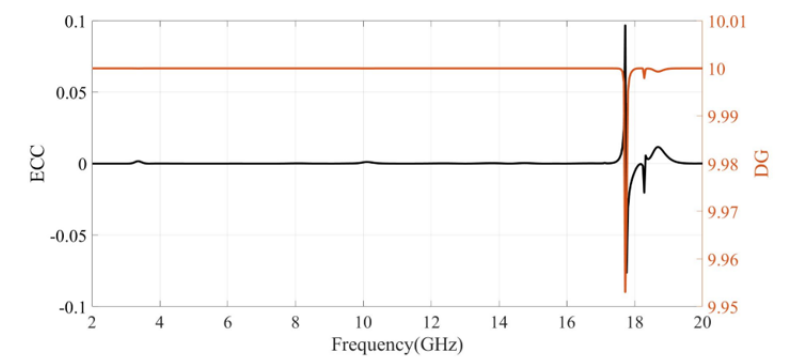
Figure 10. Envelope correlation coefficient (ECC) and diversity gain of antenna vs. frequency.